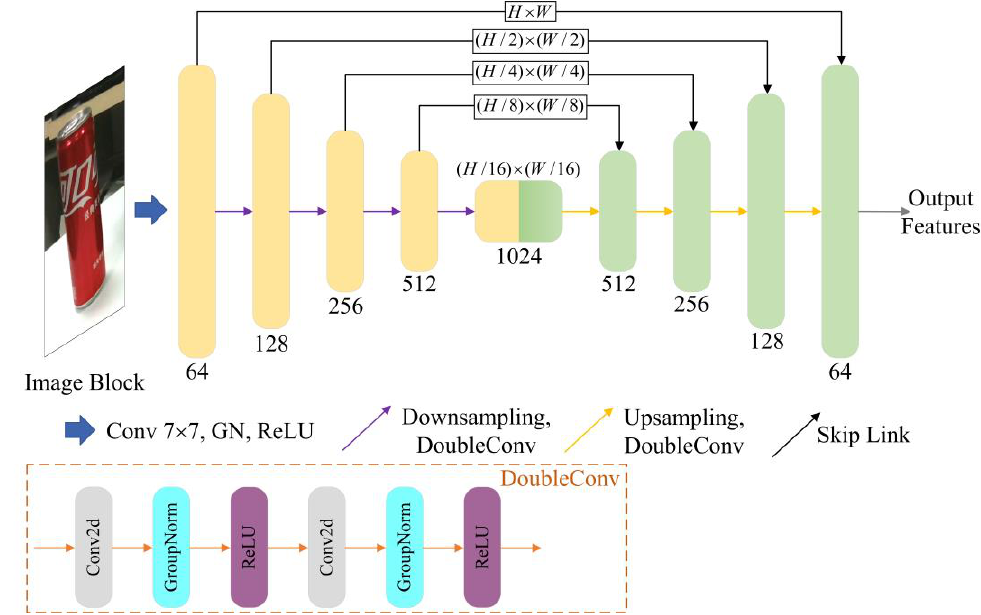
Figure 2. The structure of our image feature extraction module. The input of the module is an image block obtained by bounding box cropping, and the output is a feature map of the image block.